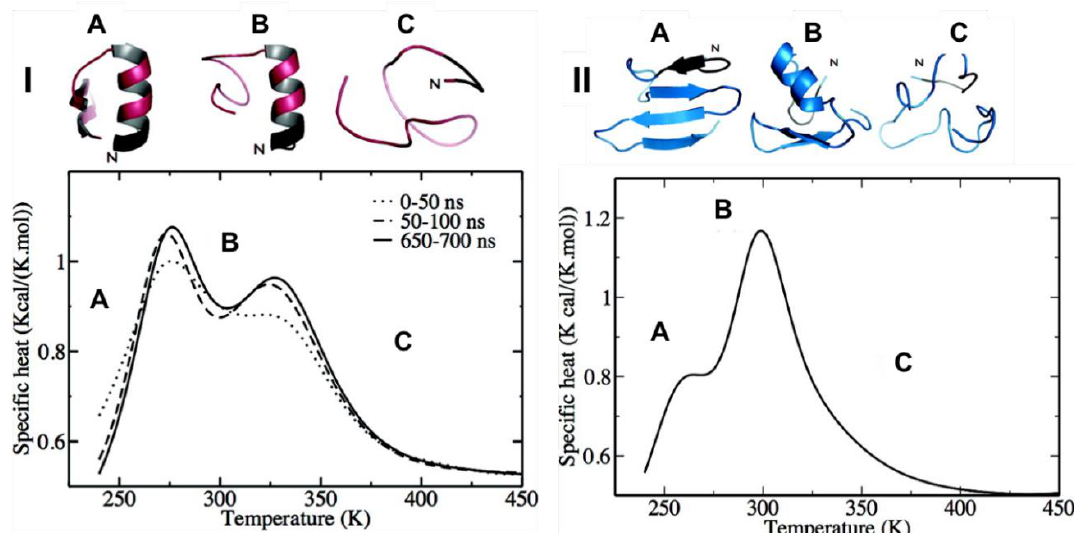
Figure 8. Specific heat capacity as a function of temperature at different time intervals for: ( I ) HT-REMD of hIAPP with representative structures for each peak, ( II ) HT-REMD of R-hIAPP with representative structures for each peak labelled A, B and C. Adapted from Laghaei et al. [74]. Copyright 2010 American Chemical Society.